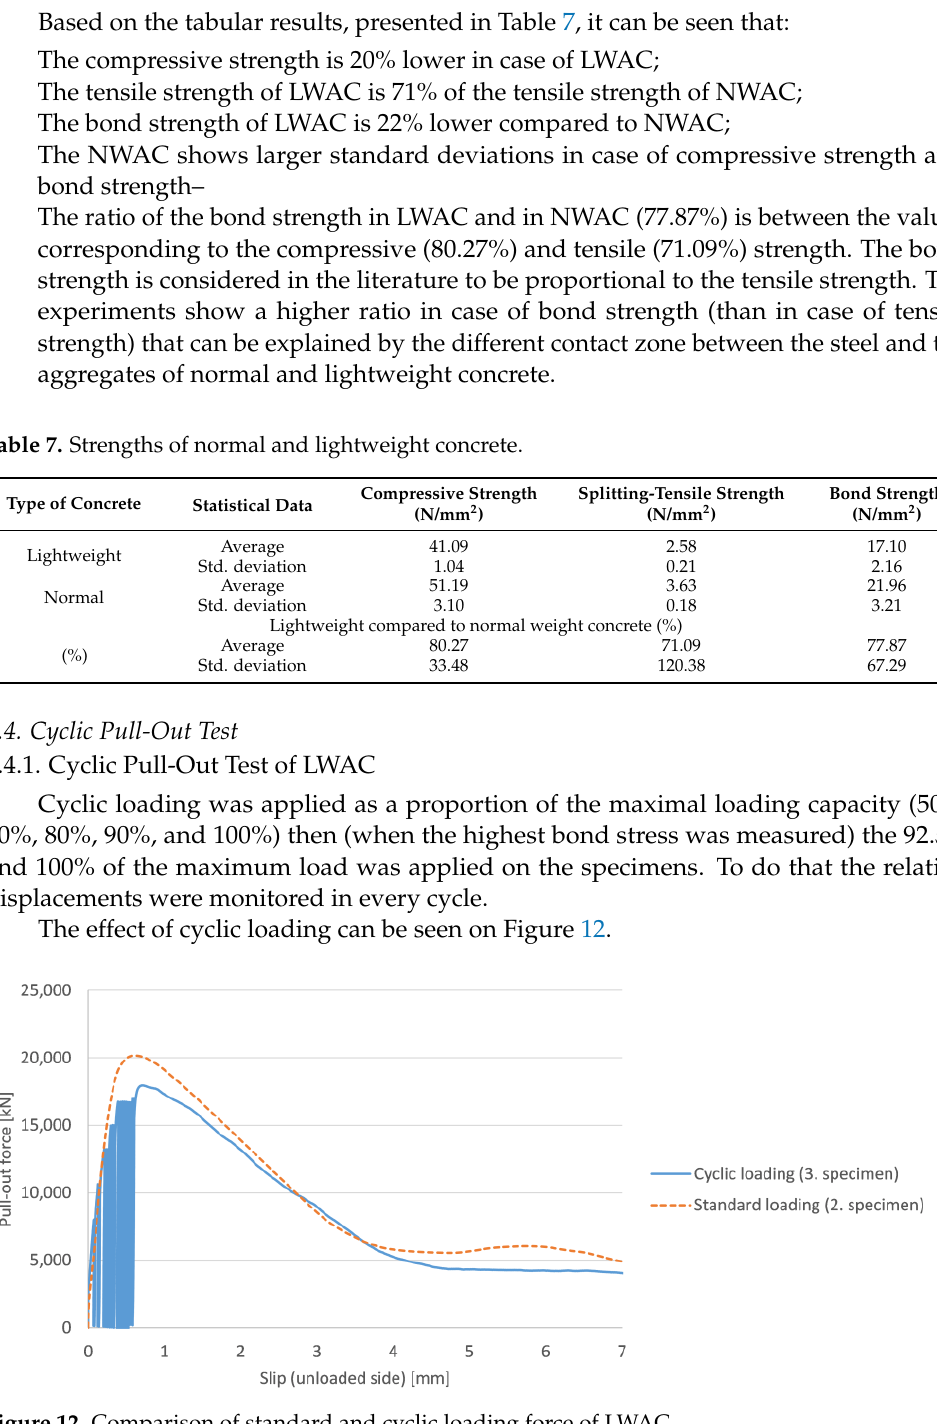
Figure 12. Comparison of standard and cyclic loading force of LWAC.